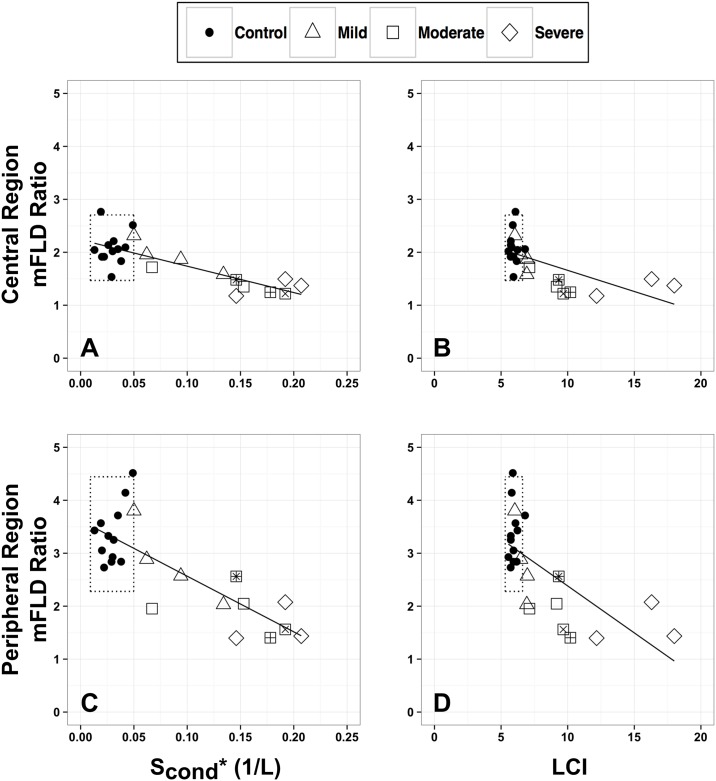
MBW indices (Scond*, LCI) vs. the mFLD ratio in both lung regions.(A,C) Scond* (1/L) and (B,D) LCI vs. mFLD ratio in the (A,B) central and (C,D) peripheral region. Data presented for 12 healthy controls 12 CF adults with stable disease (4 had mild (FEV1 > 80%), 5 had moderate disease (50%<FEV1<80%), and 3 had severe disease (FEV1<50%)). Dotted lines are range of control subjects in study (i.e mean ± 1.96*SD). Individual subjects with similar FEV1 [%pred] and LCI 2% are identified by +, * and ×.